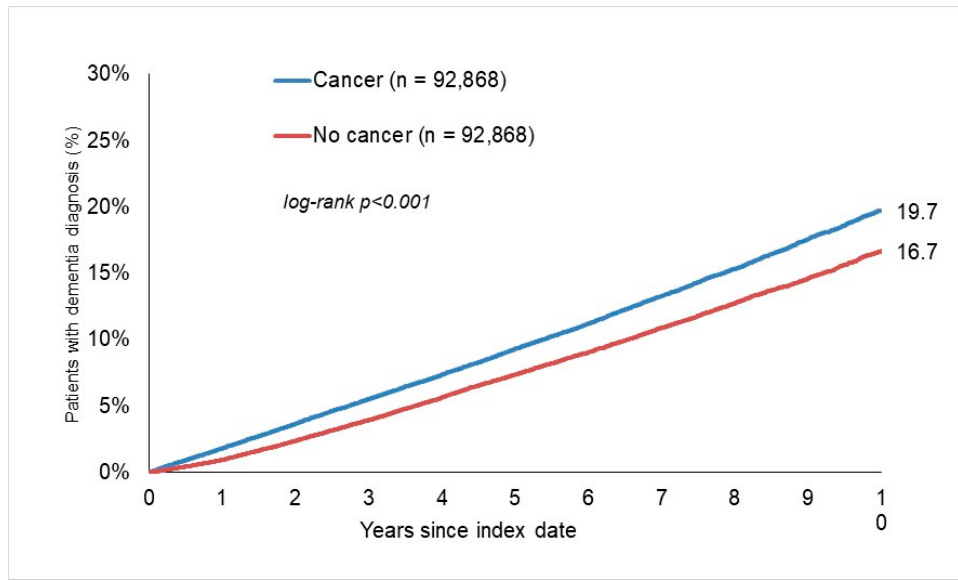
Figure 2. Ten-year cumulative incidence of dementia diagnoses in patients with and without cancer.